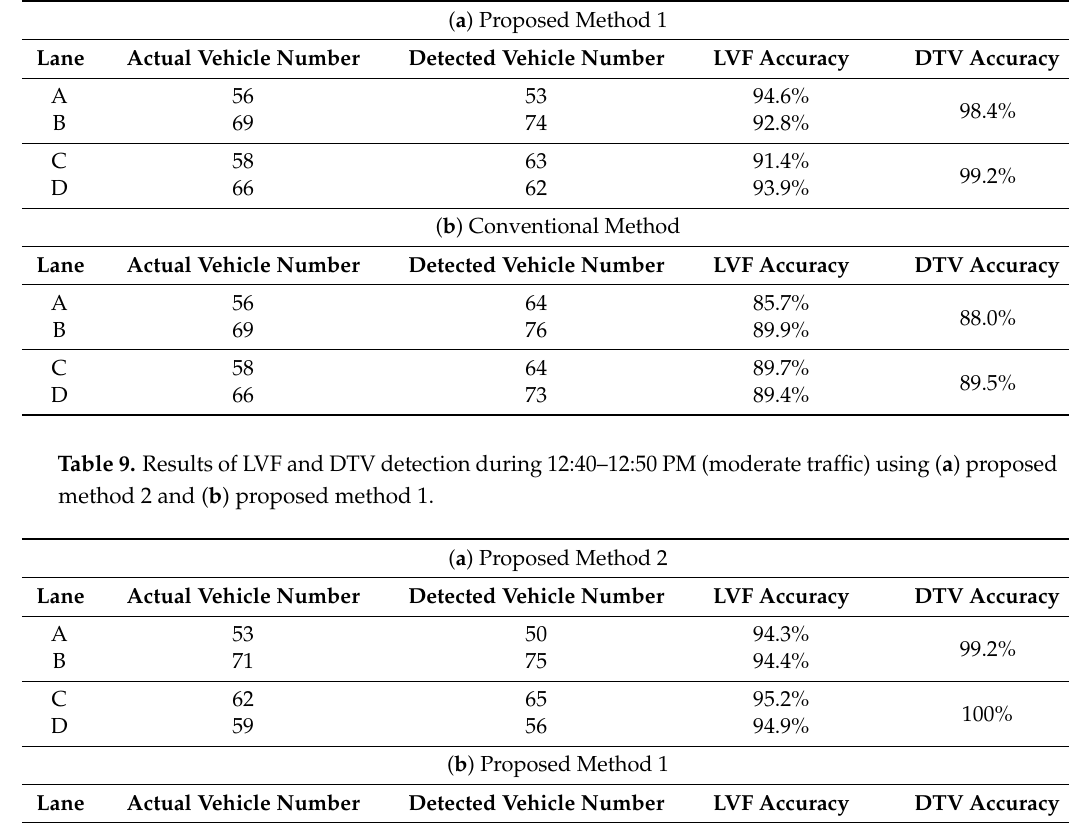
Table 8. Results of LVF and DTV detection during 12:20–12:30 PM (moderate traffic) using ( a ) proposed method 1 and ( b ) conventional method.